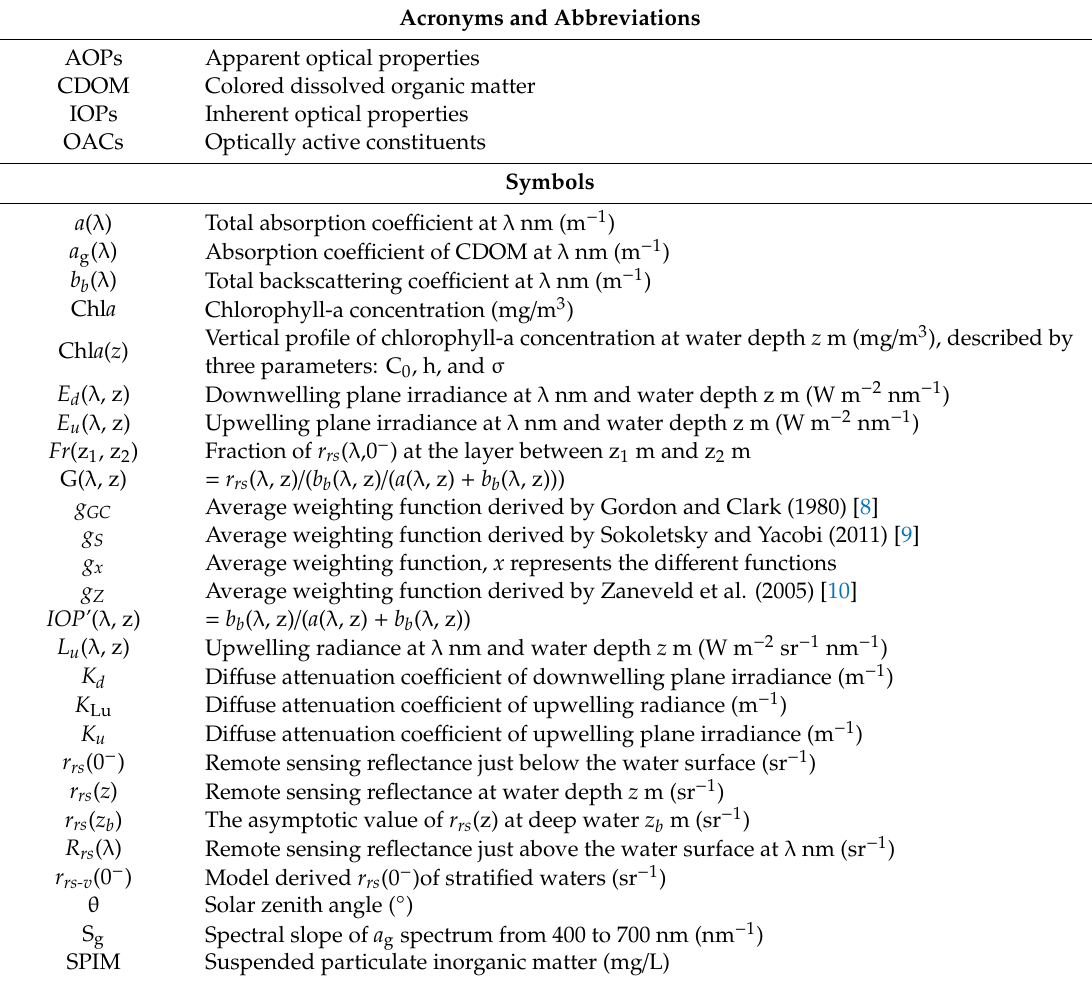
Table 1. Acronyms, abbreviations, and symbols of the parameters used in this